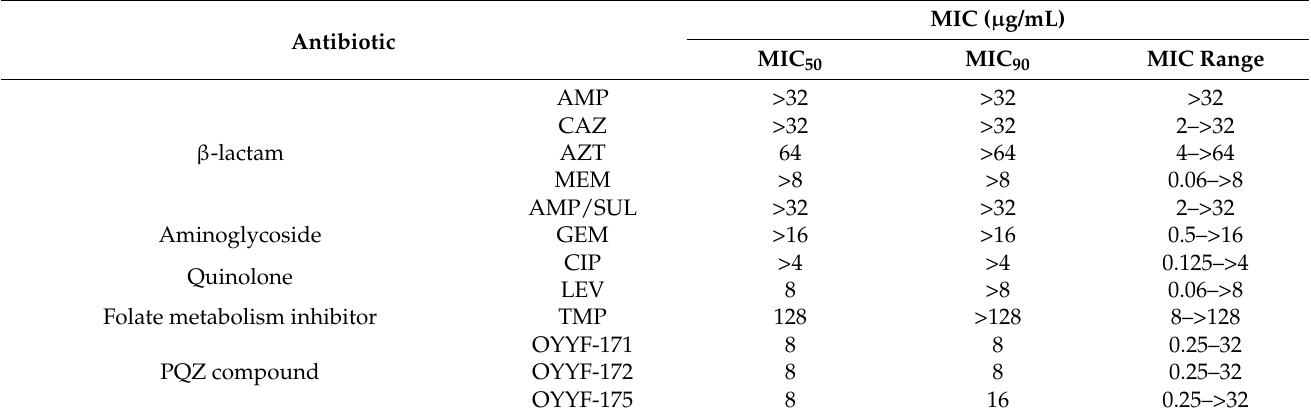
Table 3. The MIC 50 /MIC 90 values of PQZ compounds and reference antibiotics against 40 clinical isolates of A. baumannii